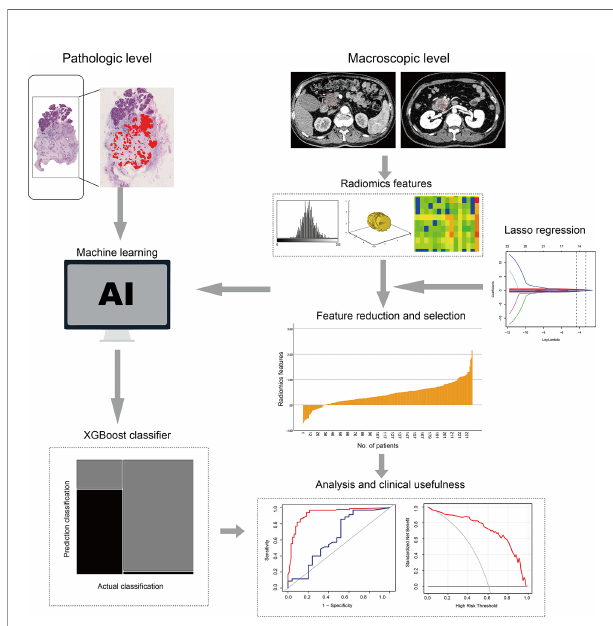
FIGURE 2 | Radiomics work fl